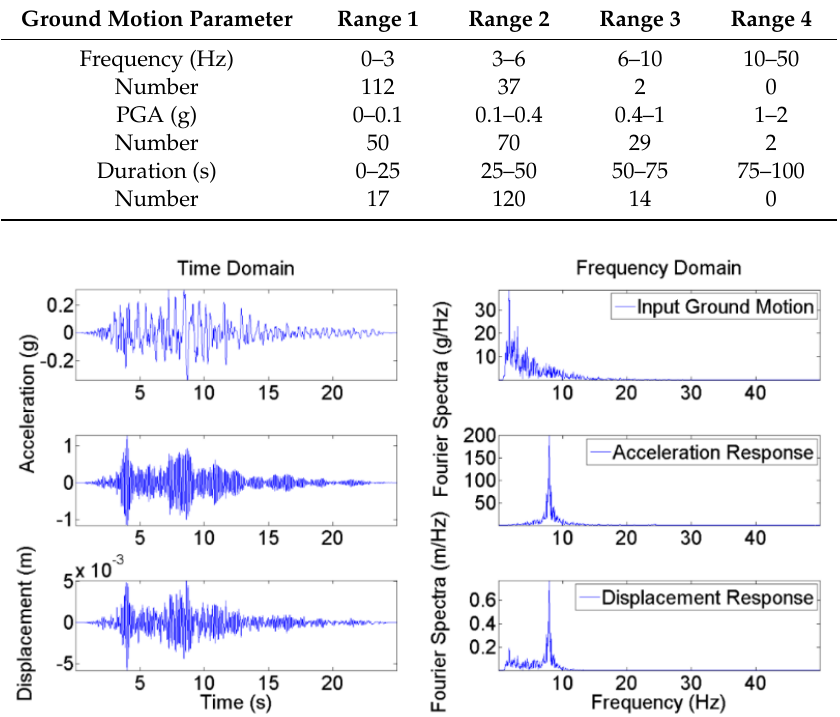
Figure 10. Exemplary input ground motion and simulated structural response.